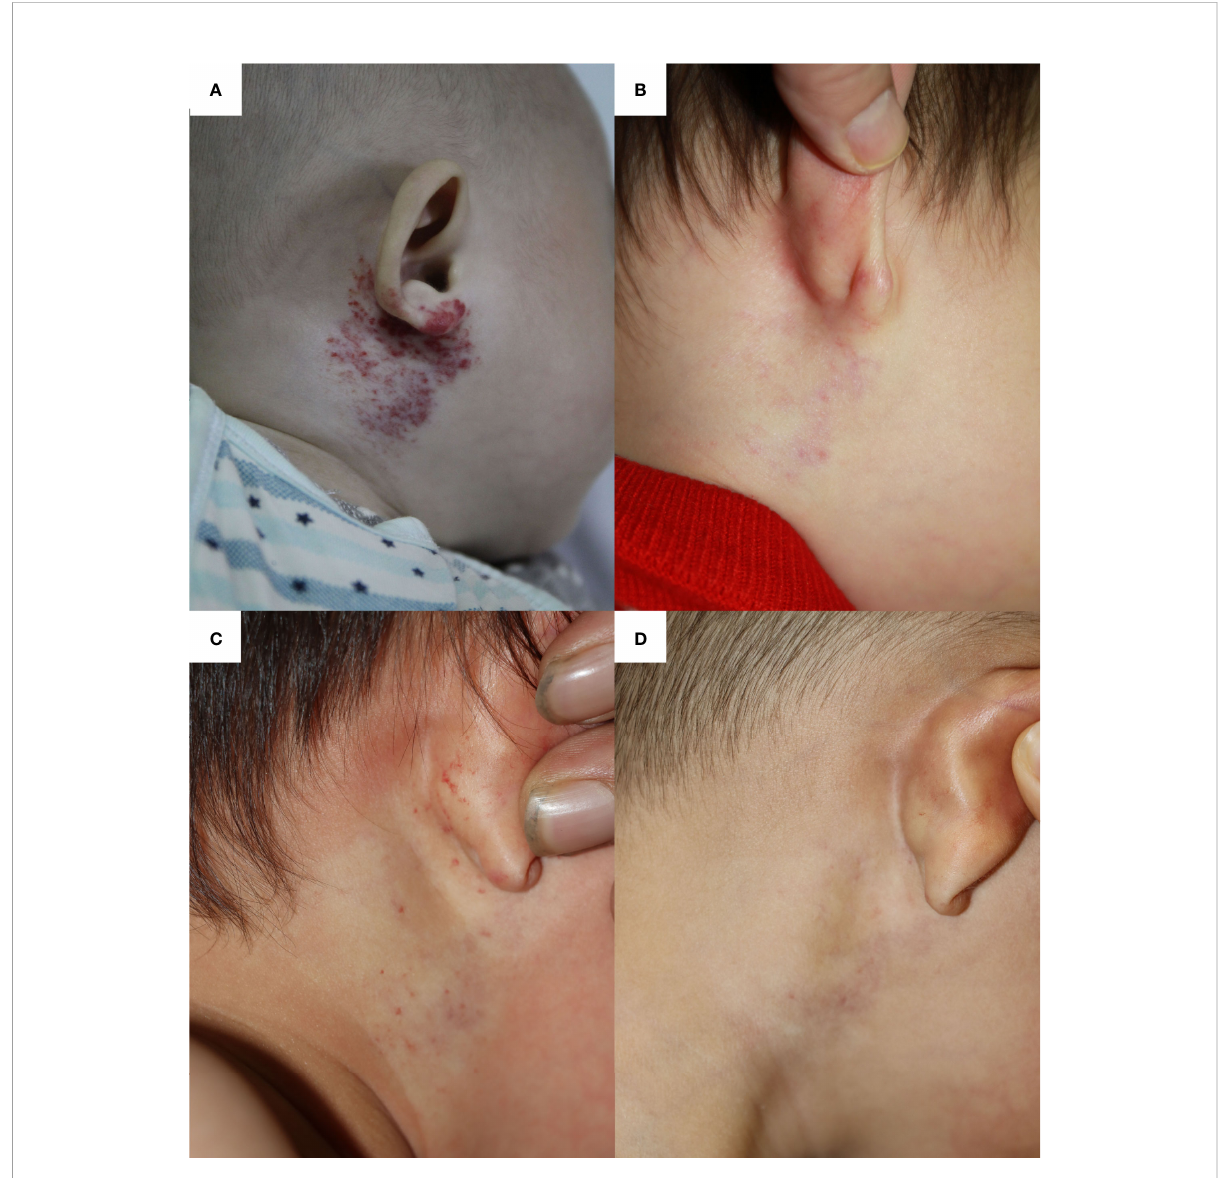
FIGURE 3 The infantile hemangioma in patient 3 at different periods. (A) Proliferating infantile hemangioma before oral propranolol therapy and laser therapy. (B) Involuted infantile hemangioma when the patient had completed the 10-month oral propranolol therapy and nine times of laser therapy at the age of 14 months. (C) Deterioration of infantile hemangioma after receiving 6 days of oral clenbuterol and nebulized salbutamol. (D) Involuted hemangioma after 1 month of oral propranolol therapy and one laser